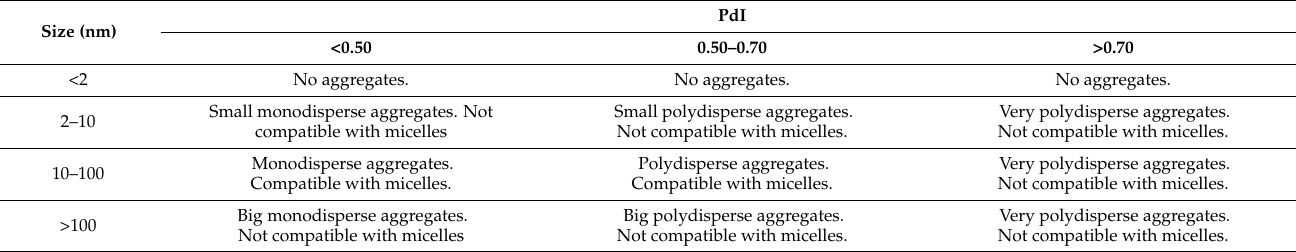
Table 3. Micelle detection chart, considering the size and PdI of the aggregates